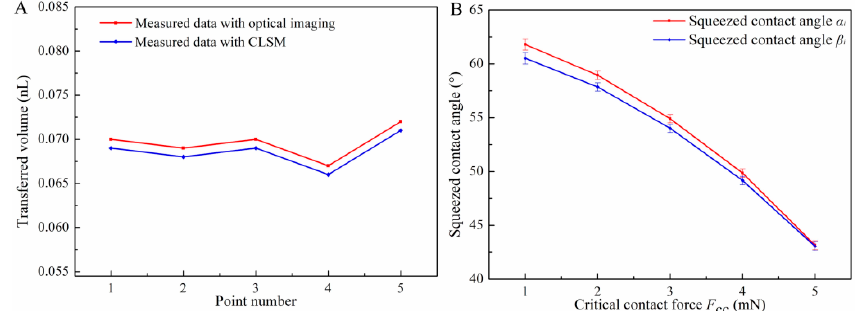
Figure 6. ( A ) Measurement difference of transferred volume at 1 mN, and ( B ) squeezed contact angles α i and β i at 1~5 mN with initial volume 0.15 nL.